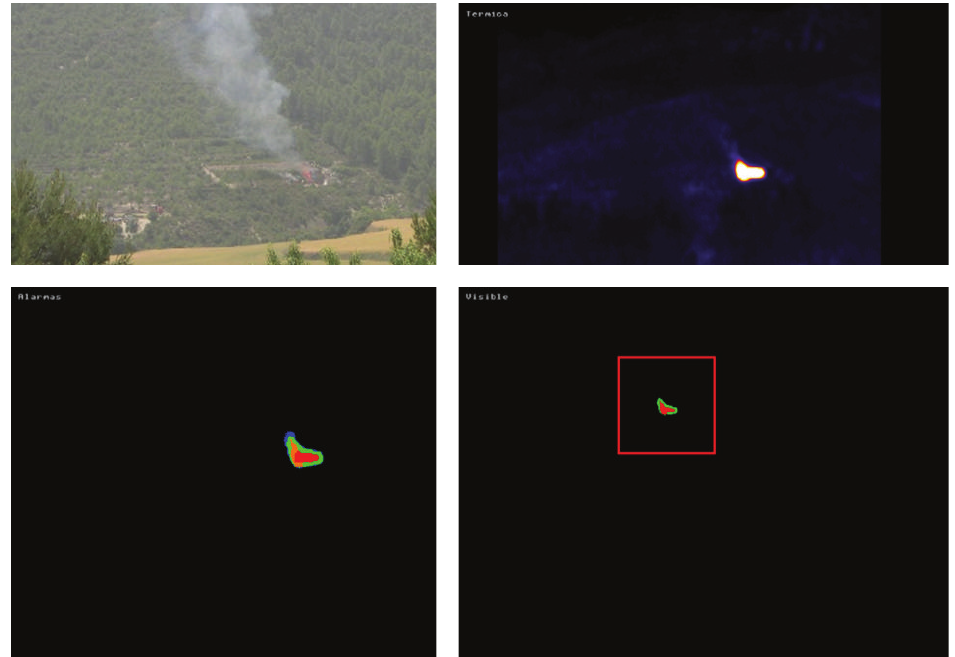
Figure 7: Example of controlled fire detection in real